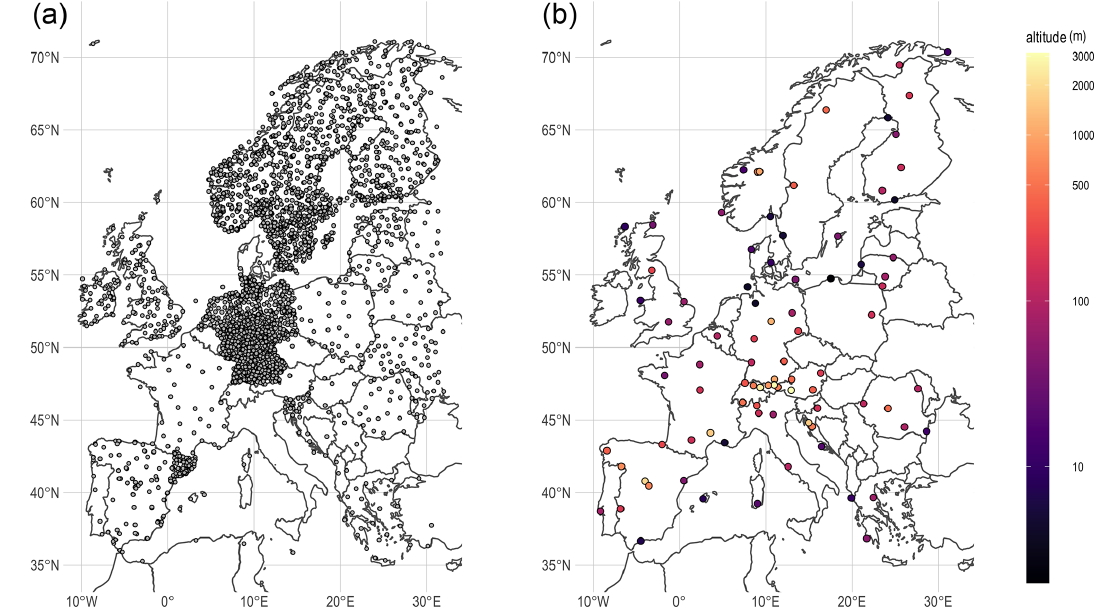
Figure 3. Locations of ECA&D (a) and VALUE (b) stations, with altitude shaded.